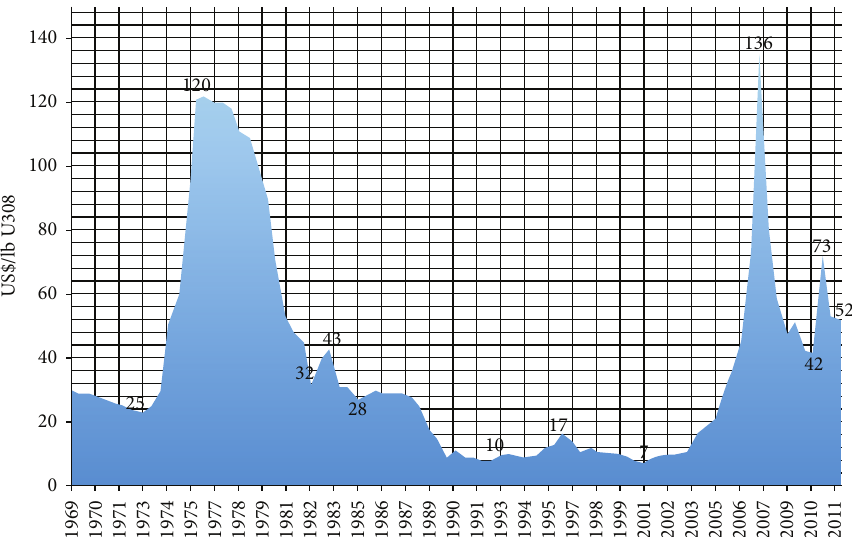
Figure 1: Uranium spot prices 1969–2012. Source: (1969–1989, NUEXCO Exchange Value, UX Consulting, constant 2007$; 1989–present, CAMECO,